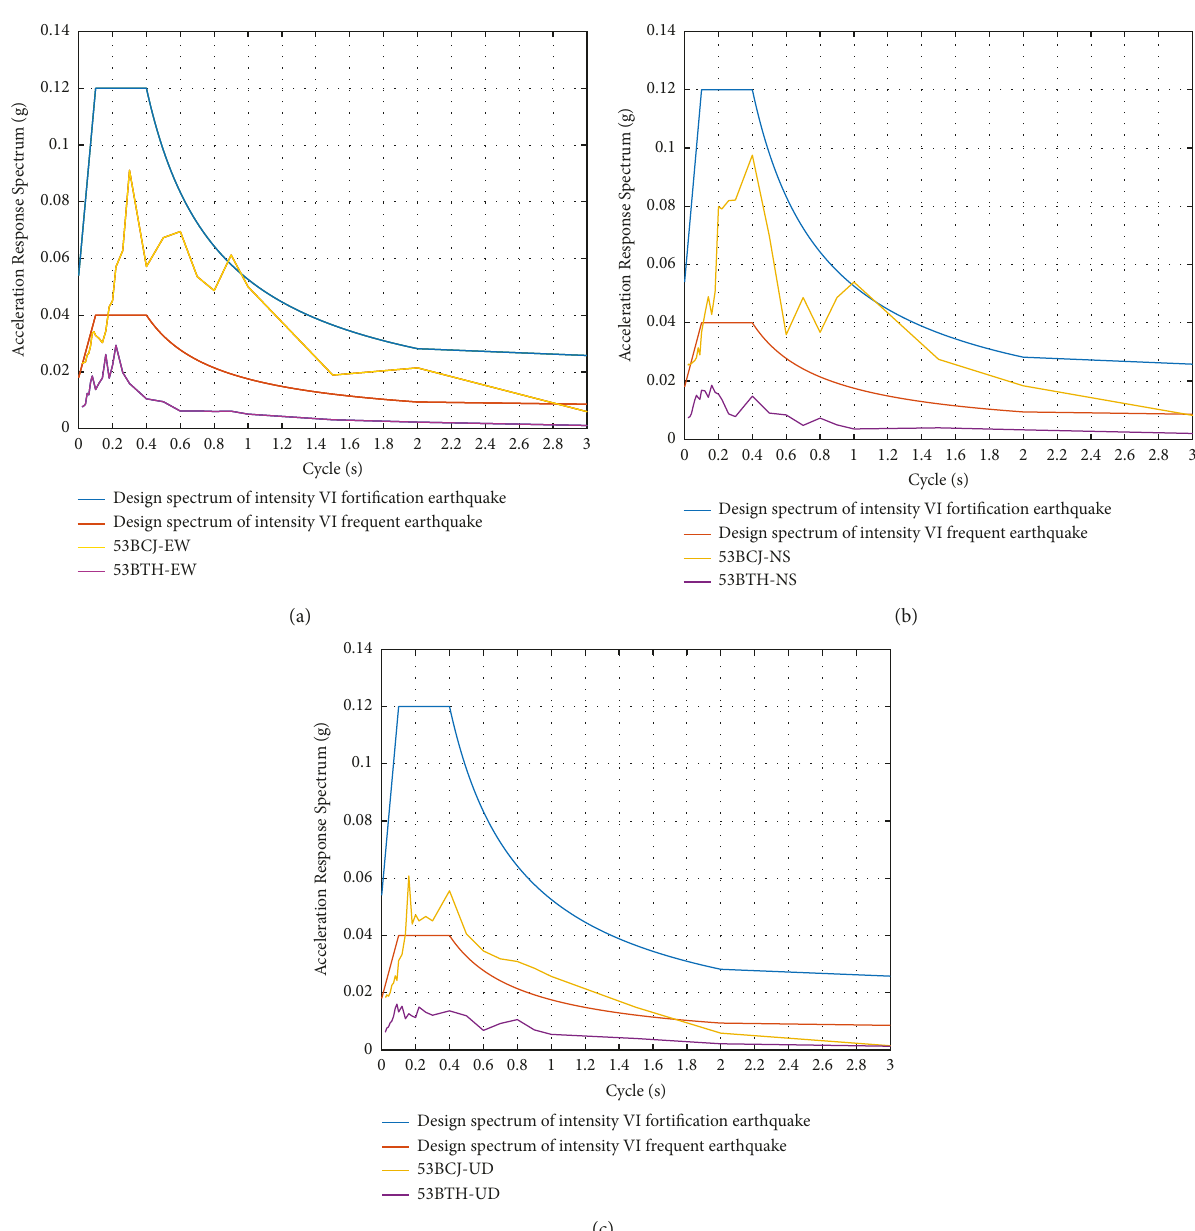
Figure 7: Comparison of acceleration response spectra (Sa) and code design spectra between a soil station (53BCJ) and a rock station (53BTH): (a) east-west; (b) north-south; and (c) vertical.